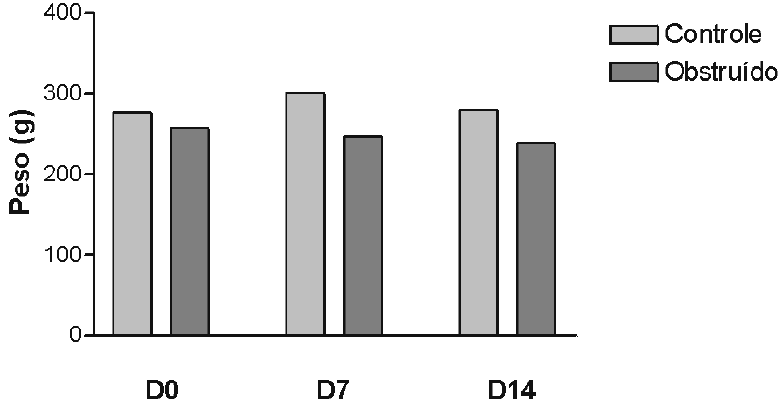
Figura 1 - Variação da média dos pesos em ambos os